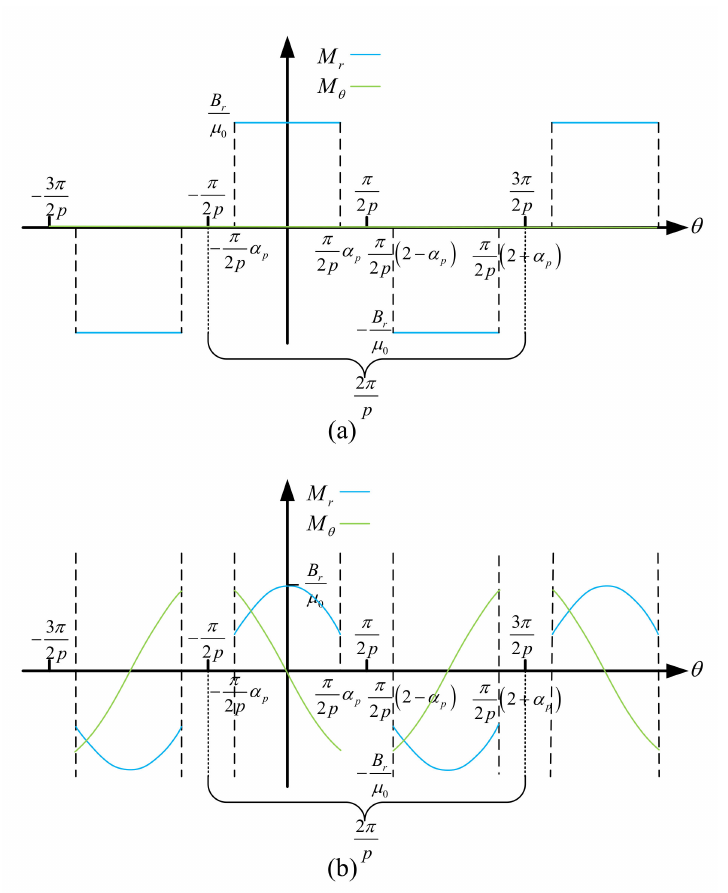
Figure 8. Waveforms of magnetization components M r and M θ . ( a ) Radial magnetization. ( b ) Parallel